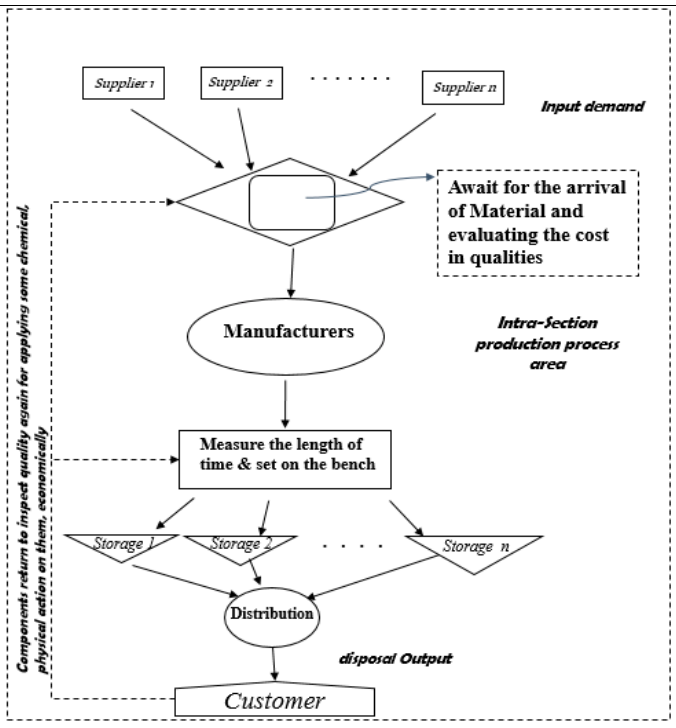
Figure 2. Conceptual Model for Flow process chart of manufacturing supply chain system.